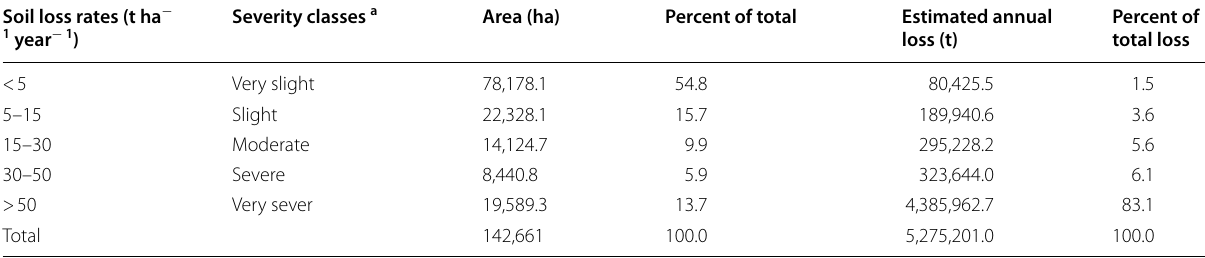
a This classification was made based on FAO (2006), Haregeweyn et al. (2017) and Yusuph and Dagnew (2019)